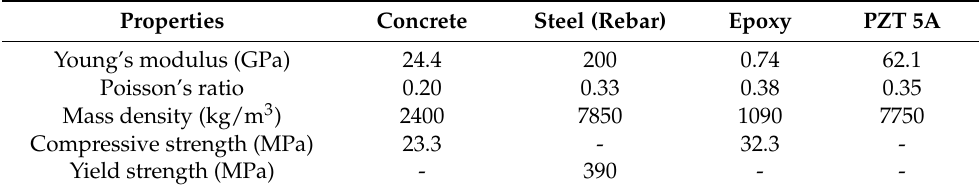
Figure 9. FE model of smart rebar–aggregate under compressive force (unit in mm): ( a ) Rebar–aggregate in concrete sample; ( b , c ) Detailed meshing at rebar–aggregate. Table 2. Material properties of concrete, steel, and epoxy adhesive, PZT